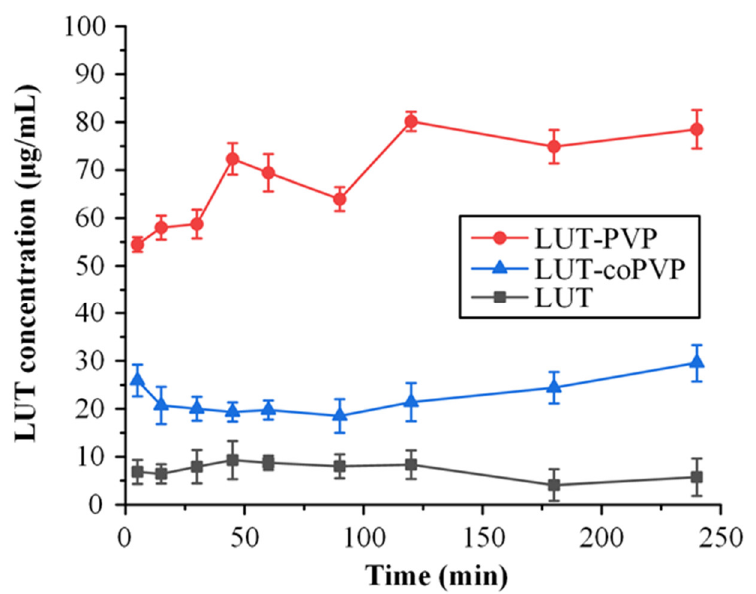
Figure 3. LUT concentration profile during the evaluation of matrix/carriers based on the solvent shift method.